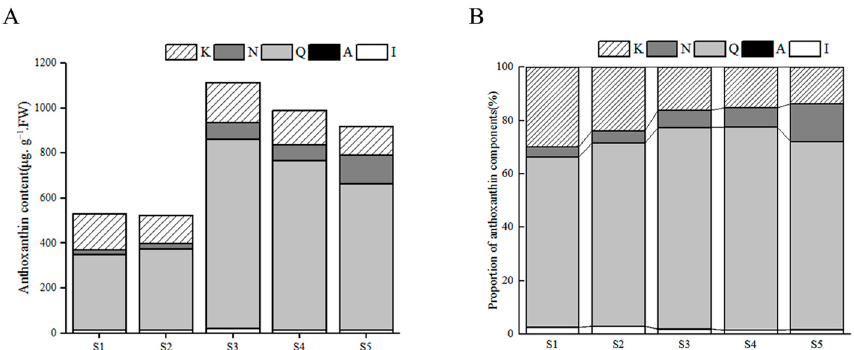
Figure 3. The accumulation of anthoxanthins in petals of ‘QN’ at different development stages. ( A ) Content of individual anthoxanthin component. ( B ) Percentage of individual anthoxanthin component. K stands for kaempferol and its derivatives; N stands for naringin and its derivatives; Q stands for quercetin and its derivatives; A stands for apigenin and its derivatives; I stands for isorhamnetin and its derivatives.